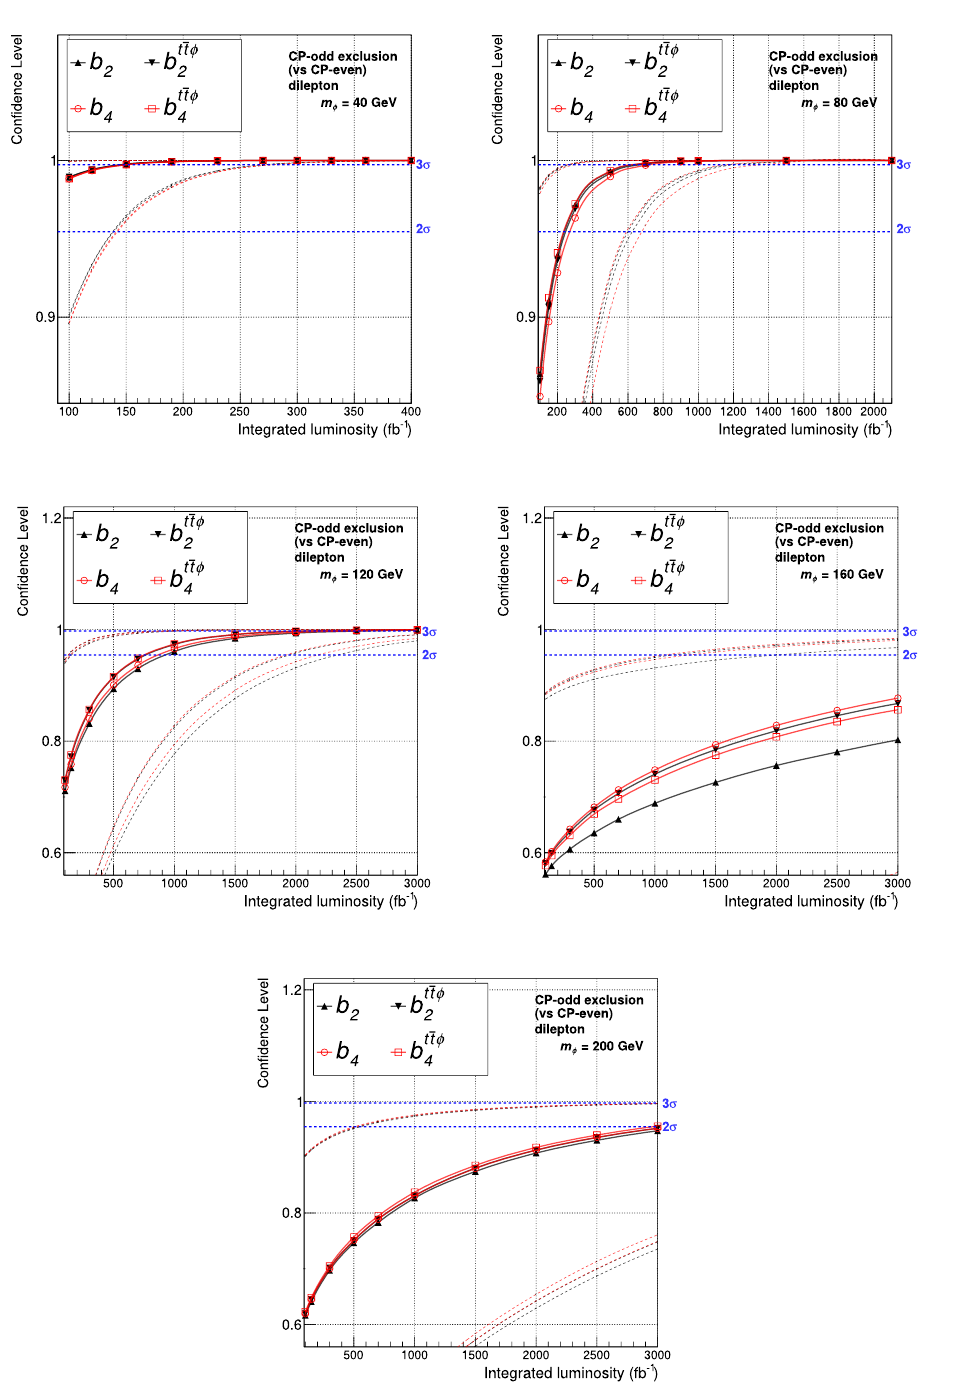
Figure 19. Expected CLs for CP-odd exclusion assuming the SM plus a new CP-even scalar particle (scenario 3), as a function of the integrated luminosity.